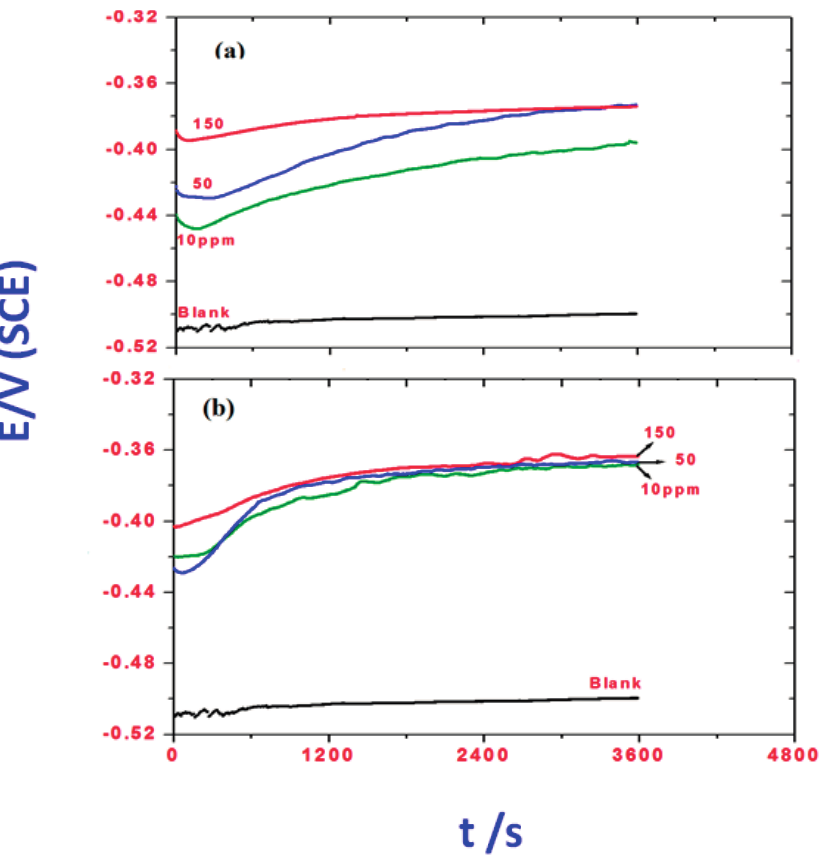
Figure 9. The change of open circuit potential of steel electrode as a function of immersion time in 1 M HCl solution and containing various concentrations of ( a ) OA-TS and ( b )